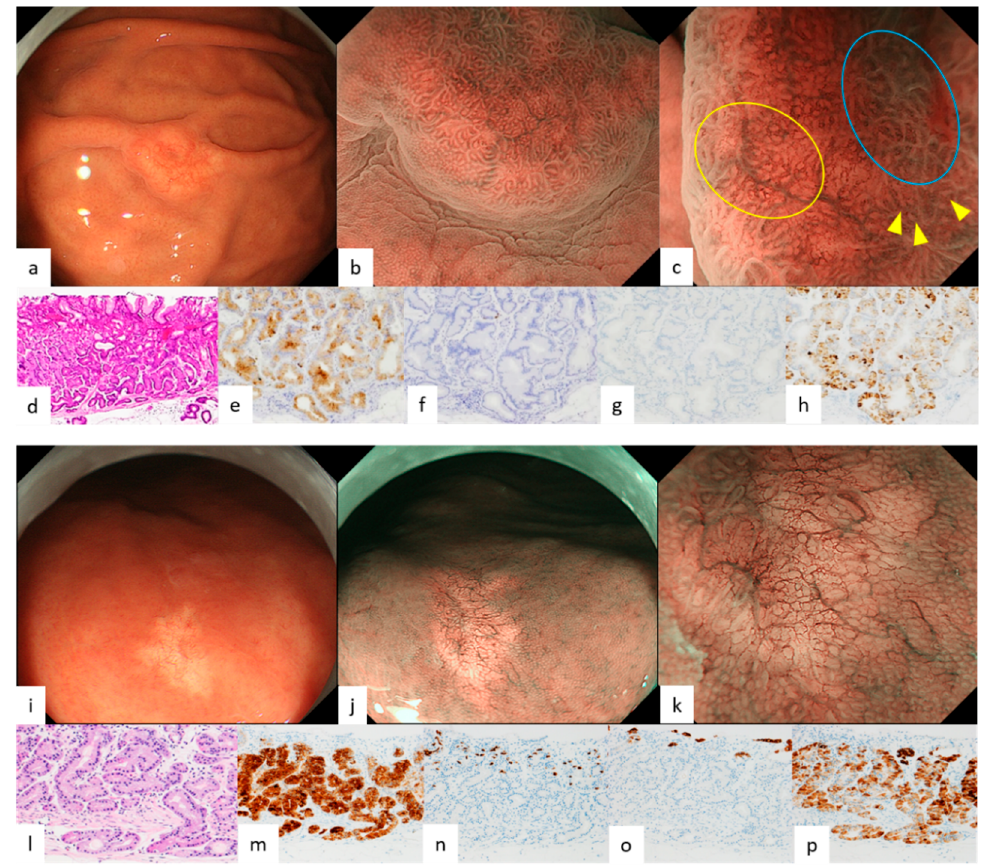
Figure 1. Endoscopic and pathological findings of GA-FG (whitish elevated type, whitish flat or depressed type). ( a ) WLI. An elevated lesion, 15 mm in size, was found in the greater curvature of the upper body of the stomach. Whitish color, SMT shape, and dilated vessels with branching ar- chitecture were observed, with no atrophic changes in the background mucosa; ( b , c ) M-NBI. Dila- tation of CO (yellow arrowhead), dilatation of IP (blue circle), and microvessels without distinct irregularity were observed, but a distinct DL was not observed. These findings are all congruent with our previously reported endoscopic features. Microvessels without distinct irregularity flowed into the collecting venules (yellow circle). A regular MV pattern plus regular MS pattern without a DL was observed by the MESDA-G; the lesion was diagnosed as non-cancerous; ( d ) HE stain. The surface layer was covered by non-neoplastic mucosa, and tumor cells similar to chief cells prolifer- ated primarily in the deep mucosa, showing an irregular branching structure and adhesion. The nuclei of tumor cells were slightly enlarged compared with those of the surrounding non-neoplastic fundic gland tissue; ( e – h ) Immunostain; ( e ) pepsinogen-I (chief cell). Diffusely positive; ( f ) H+/K+- ATPase (parietal cell). Partially positive; ( g ) MUC5AC (gastric foveolar epithelial cell). Negative; ( h ) MUC6 (gastric mucous neck cell). Diffusely positive; Final pathological diagnosis: U, type 0-IIa, 23 mm, gastric adenocarcinoma of fundic gland type, pT1b/SM1 (400 μ m), UL0, Ly0, V0, HM0, VM0. ( i ) WLI. A whitish flat or depressed lesion 8 mm in size was found on the anterior wall of the greater curvature of the gastric body. Atrophic changes were not noted in the background mucosa, and dilated vessels with branching architecture were found in the surface layer; ( j , k ) M-NBI. No distinct DL was noted, and microvessels without distinct irregularity were also observed. A regular MV pattern plus absent MS pattern without a DL were observed by MESDA-G; the lesion was diagnosed as non-cancerous; ( l ) HE staining image. Tumor cells similar to chief cells proliferated primarily in the deep mucosa and partially invaded the submucosal layer up to 50- μ m deep; ( m – p ) Im-